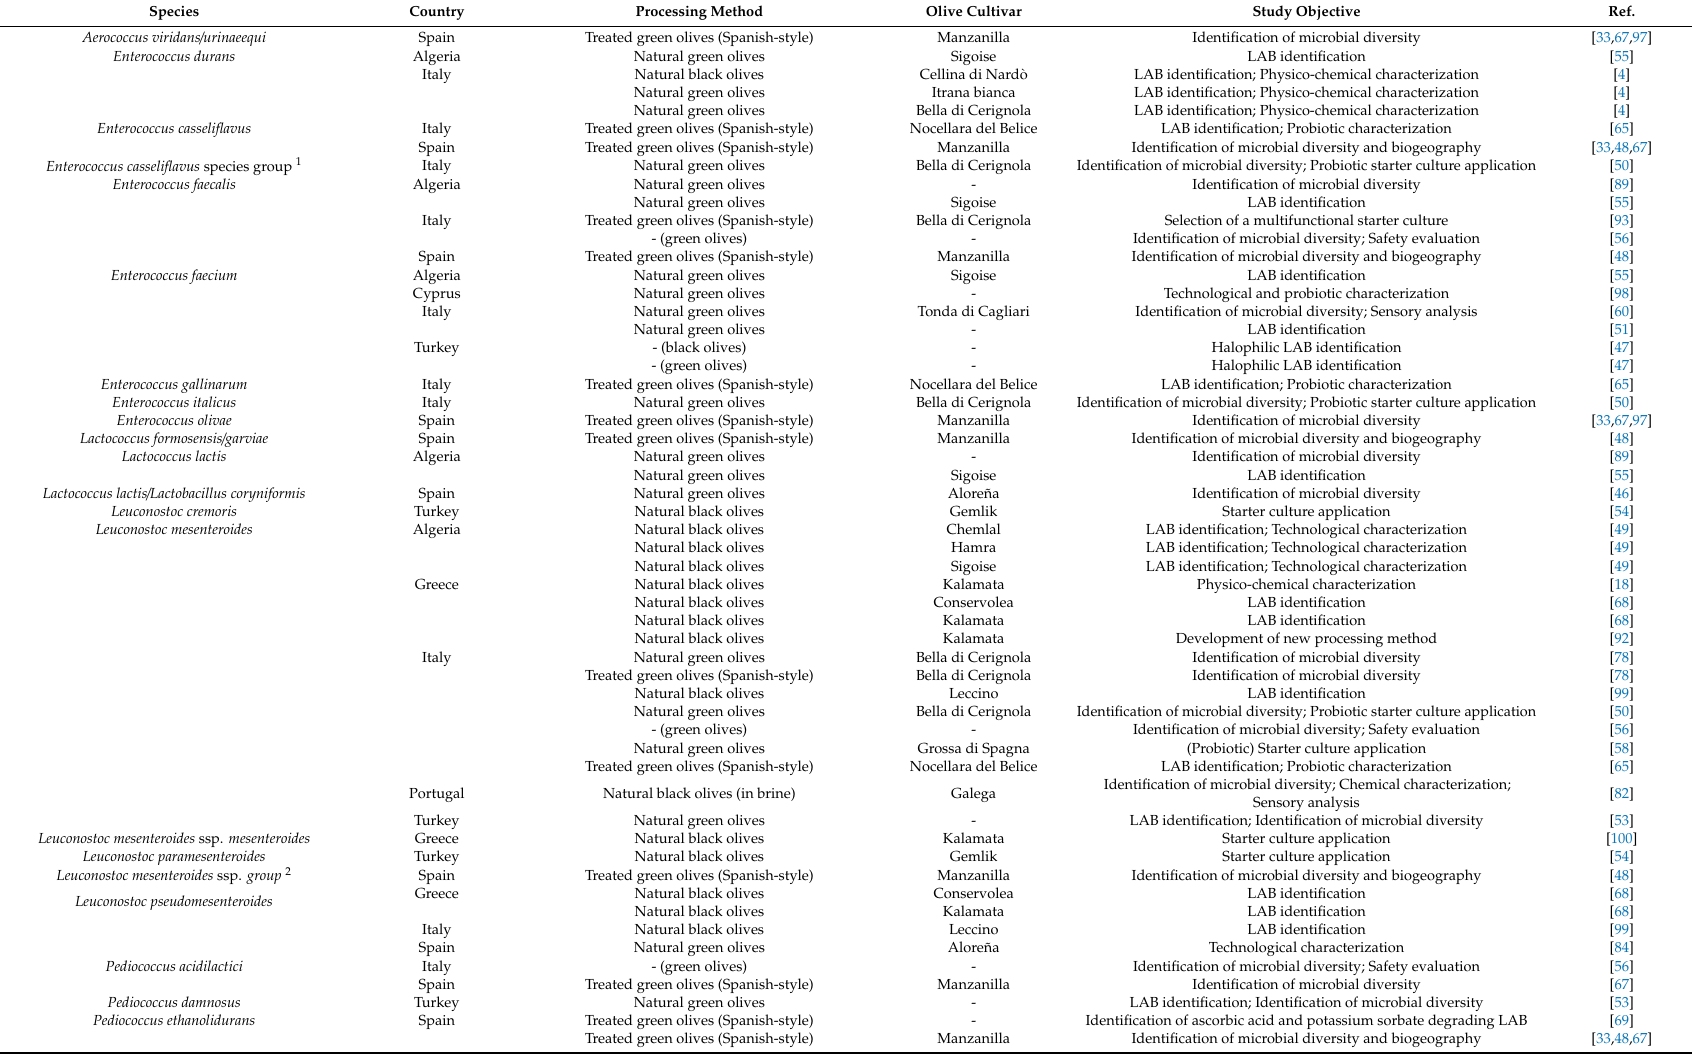
Table 3. Lactic acid bacteria (LAB) species (except Lactobacillus ) isolated from di ff erent processing methods of table